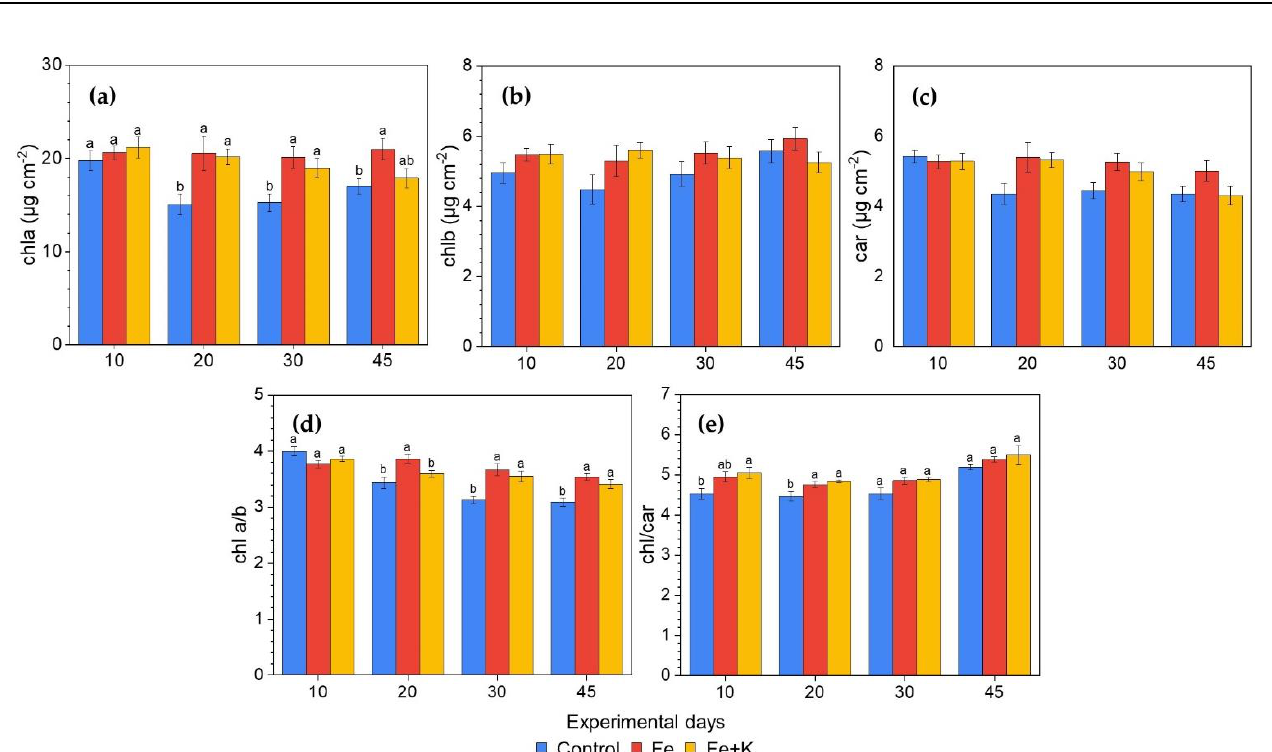
Figure 3. Gas exchange measurements during the experimental period. ( a ) photosynthetic rate (A); ( b ) stomatal conductance (g s ); ( c ) transpiration rate (E) (Mean ± SEM, n = 15). Different letters indi- cate significant differences among treatments at each experimental day ( p < 0.05).